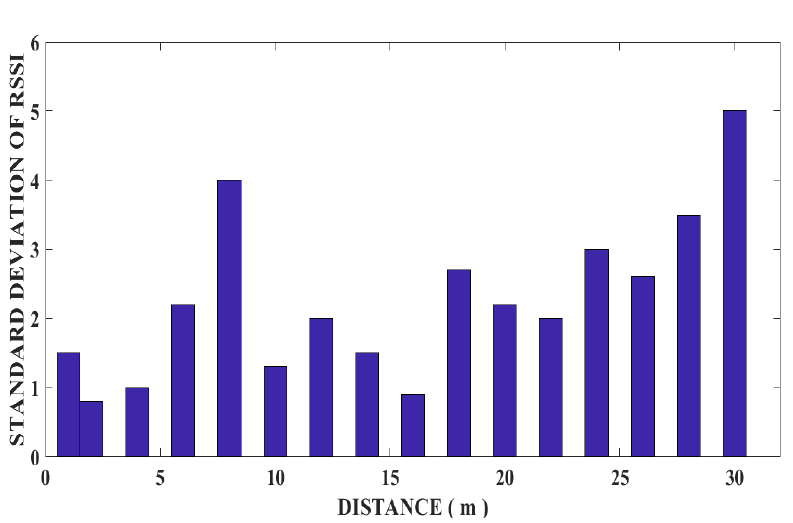
Figure 18. Standard deviation for device